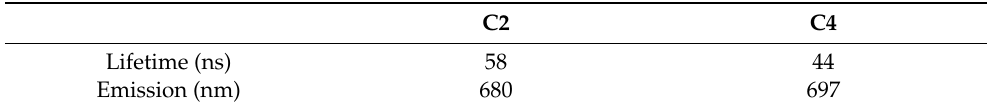
Table 7. Summary of emission properties of C2 and C4 . The other complexes did not emit at a measurable